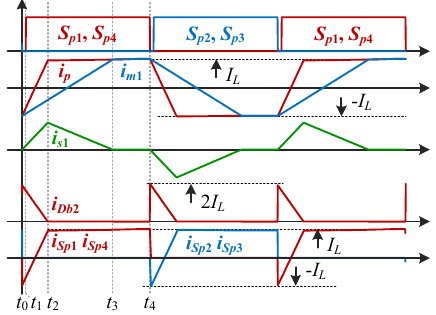
Figure 3. Theoretical waveforms of the APS.